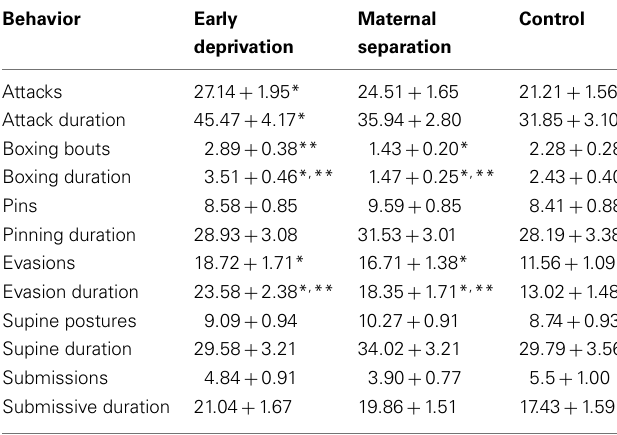
Table 1 | The effects of early deprivation and maternal separation on mean number ( + SEM) and mean total duration (seconds + SEM) of play behavior measures in adolescent